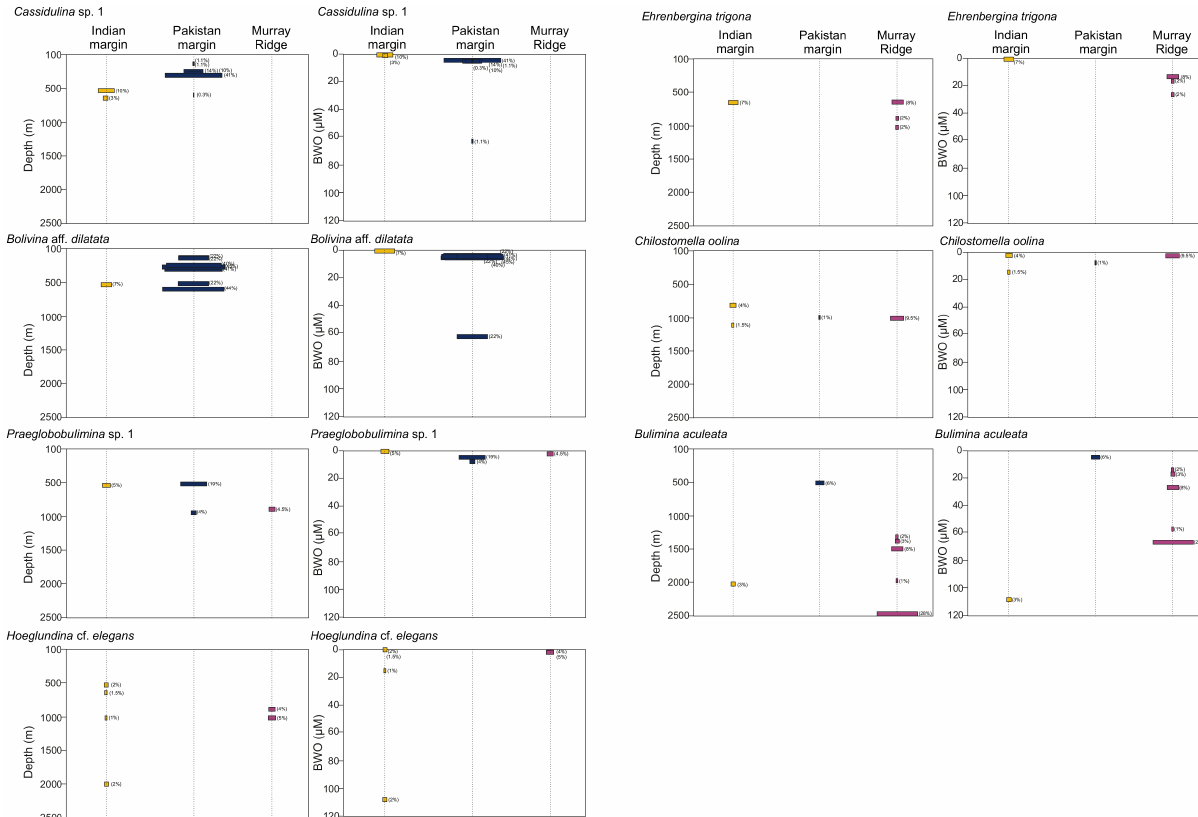
Figure 7. Comparison of species occurrences vs. depth (left panel) and BWO (µM; right panel) for three regions in the Arabian Sea. Cassidulina sp. 1 (from the Indian margin) and Cassidulina laevigata (Schumacher et al., 2007) were grouped into Cassidulina sp. Percentage species occurrences are indicated in